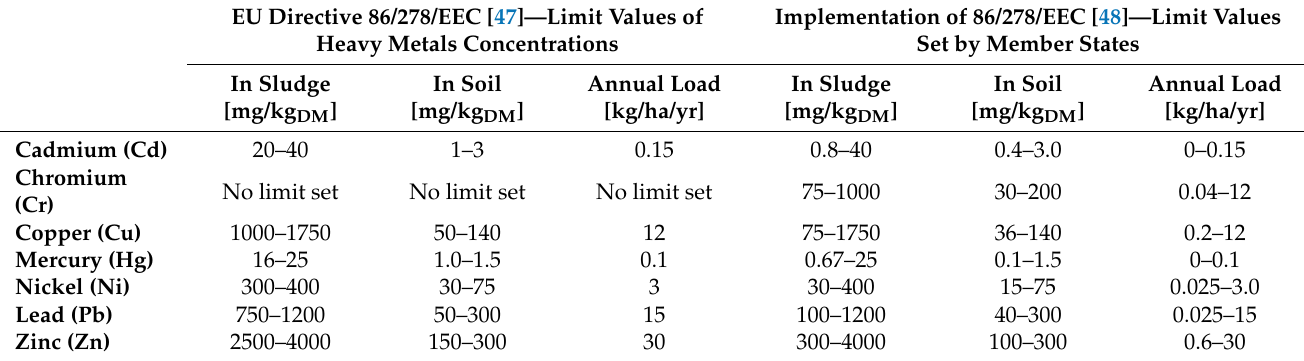
Table 3. Limit values of heavy metals in sewage sludge and agricultural